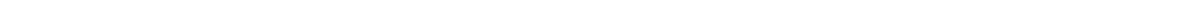
Figure 9 | CTCF depletion inhibits c H2AX nano-foci and cluster formation and diminishes the DNA repair capability. ( a ) Number of CTCF foci in esiRNA-depleted cells before and during DDR. Black dots: median number of CTCF foci in wild-type cells. ( b ) Impairment of g H2AX nano-foci and 3D- clusters formation during DDR as assessed by immunofluorescence of 3D-SIM images in CTCF-depleted cells. Scale bar, 5 m m. ( c ) g H2AX nano-foci number distributions before and after IR, in CTCF siRNA-treated cells. Black dots: median number of g H2AX nano-foci of untreated cells (from Fig. 1).NS: two-tailed t -test, P 4 0.05. ( d ) g H2AX nano-foci DNA content distributions before and after IR, in CTCF siRNA-treated cells. Black dots: median DNA content of g H2AX nano-foci of untreated cells (from Fig. 2). ( e ) DNA fragmentation measured by the neutral comet assay. Boxes represent the mean of medians from four replicates (two biological replicates in duplicate), each consisting of 60 comet measurements. NS: not significant ( t -test, P 4 0.05). ( f ) g H2AX cluster distributions before and after IR, in CTCF siRNA-treated cells. Black dots: median number of g H2AX clusters in untreated cells (from Fig. 6). All boxes and whiskers are as in Fig. 1. Comparisons between time points (one-way ANOVA with Dunnett’s correction) or between esiRNA-treated and wild-type cells (Wilcoxon/Mann–Whitney rank sum) are all statistically significant unless otherwise specified. ( g ) Model for cluster special arrangement during DDR, showing the time-dependent euchromatin-to-heterochromatin repair trend (top) and how g H2AX spreading is hampered by CTCF depletion with the concomitant loss of 3D-arrangement of chromatin loops